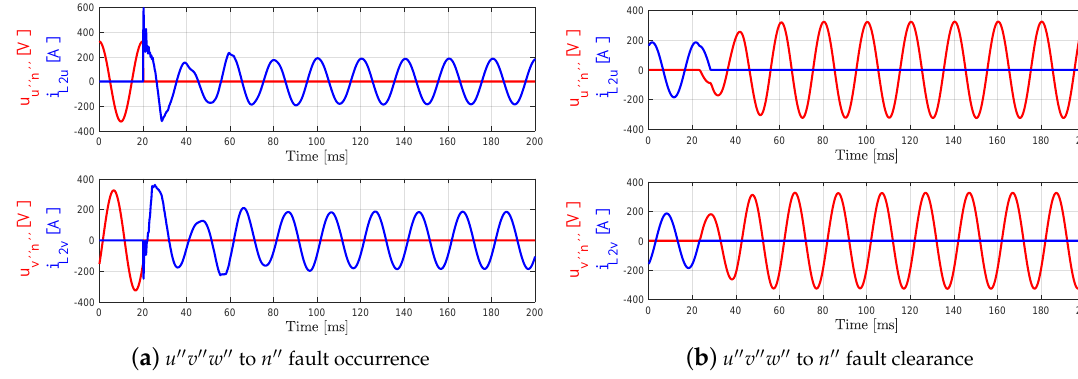
Figure 15. Scenario 4 (three-phase to neutral short-circuit).